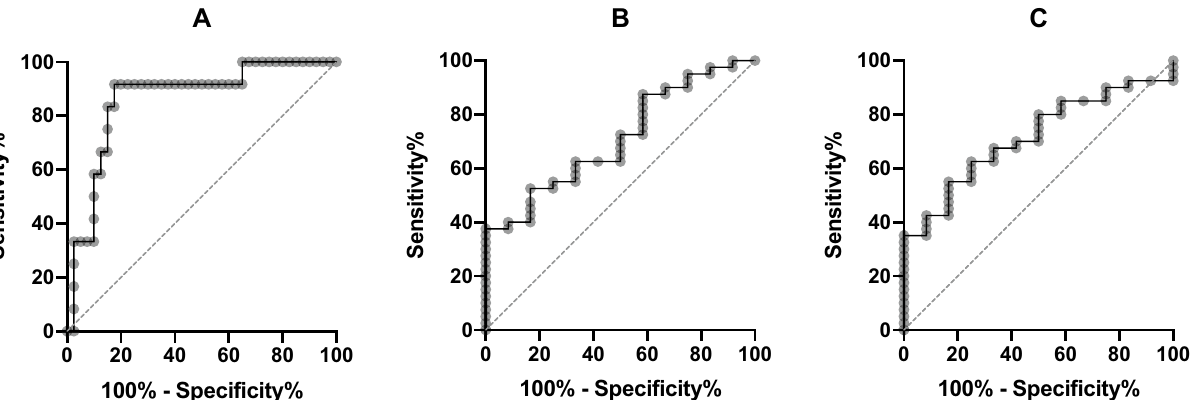
Figure 2. ROC curves of differences in EEG power value fluctuations over all channels in SE and FE patients. ( A ) relative beta (AUC 0.86, 95% CI 0.75–0.98). ( B ) relative alpha (AUC 0.71, 95% CI 0.56–0.86). ( C ) relative